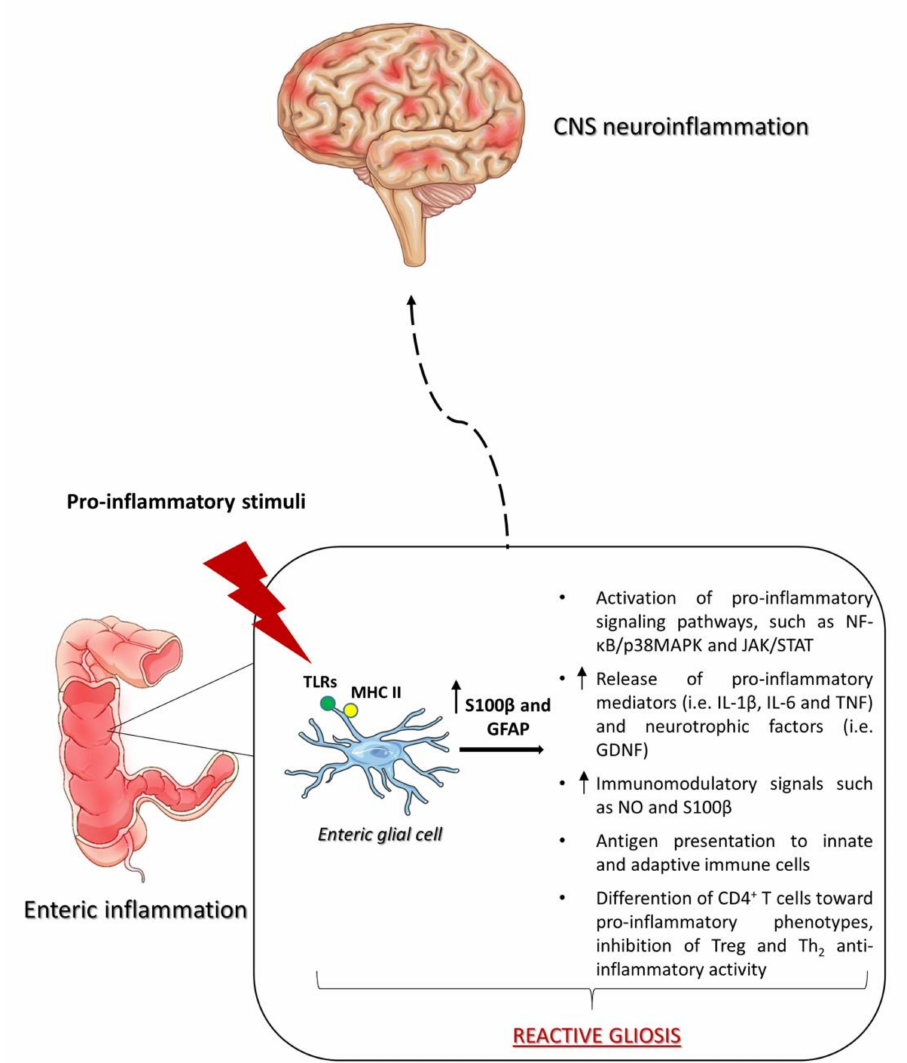
Figure 2. Role of EGCs in intestinal and CNS inflammation. In the bowel, pro-inflammatory stimuli, includingIL-1, IL-6, andLPSelicitapathologicalactivationoftheentericglia, knownas“reactivegliosis”. As a consequence, the expression of glial markers, such as GFAP and S100 β , increase significantly, triggering the release of pro-inflammatory cytokines (i.e., TNF, IL-1 β , and IL-6), glial cell-derived neurotrophic factors (i.e., GDNF), and other immunomodulatory signaling molecules, including NO and S100 β . In addition, the activated EGCs act as antigen-presenting cells at the neuron–epithelial interface, triggering an abnormal activation of CD4 + T cells. This cascade of events amplifies the pro-inflammatory environment, intestinal barrier damage, and neurochemical changes leading to a neuroinflammatory response that, somehow, ascends to the CNS. Abbreviations: CNS, central nervous system; EGC, enteric glial cell; GDNF, glial cell-derived neurotrophic factor; GFAP, glial fibrillary acidic protein; IL, interleukin; LPS, lipopolysaccharide; MHC II, major histocompatibility complex II; NO, nitric oxide; TLRs, toll-like receptors; TNF, tumor necrosis